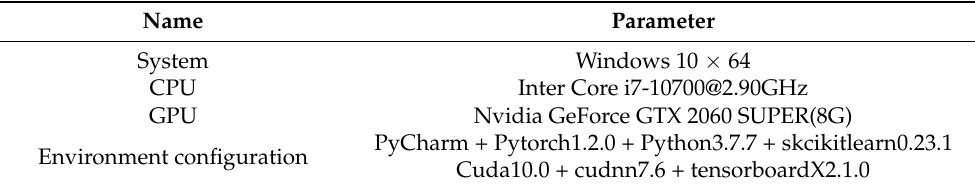
Table 3. Software and hardware environment configuration